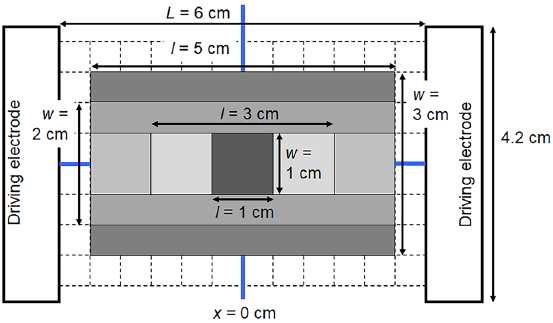
Figure 1. Top-view schematic of the experimental setup for bipolar anodization. L , l , and w denote the distance between the driving electrodes and the length and width of the BPE, respectively. The grid is drawn with a spacing of 5